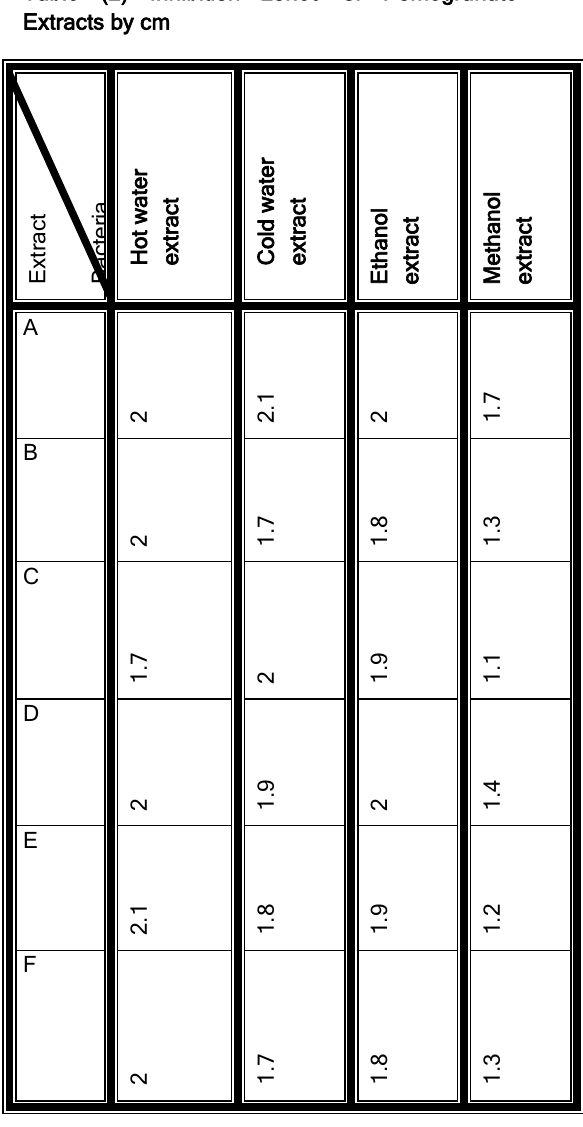
Table (2) Inhibition zones of Pomegranate Extracts by